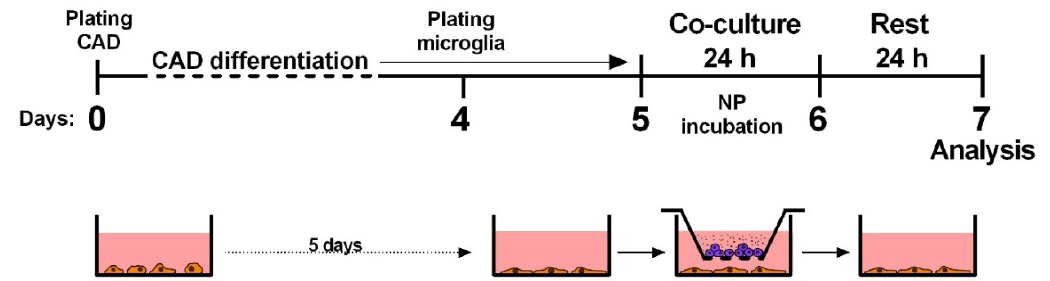
Figure 6. Schematic representation of the procedure for co-culture experiments. CAD cells were differentiated for 5 days, exposed to NP incubated microglial cells in a non-contact co-culture through a transwell system for 24 h and left another 24 h in the same conditioned medium before analysis.